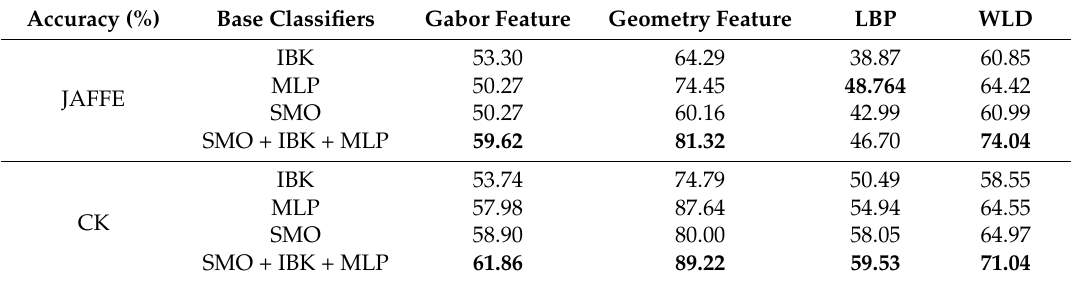
Table 8. Comparison of recognition results with a simple classifier and multi-classifiers based on AU.